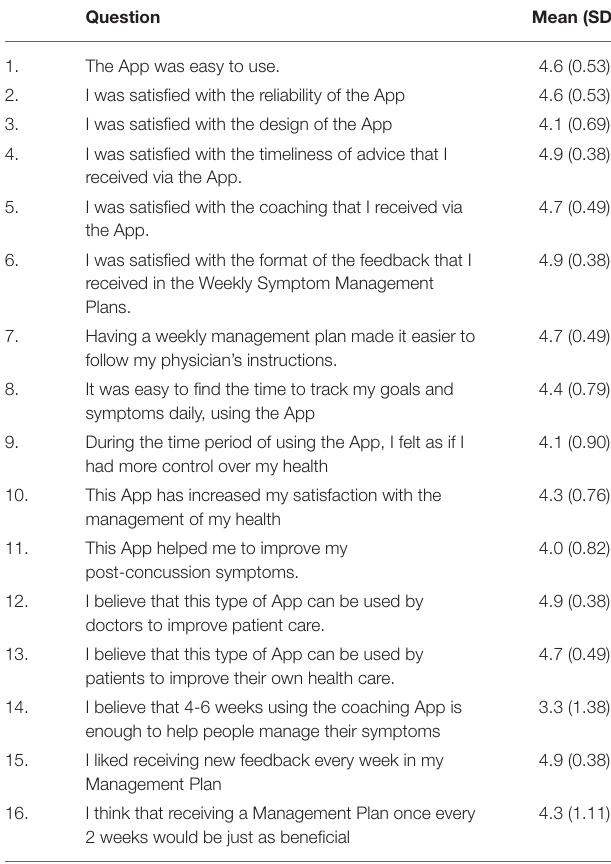
TABLE 2 | Consistency of in-app tracking and progress questionnaire completion. Participant ID